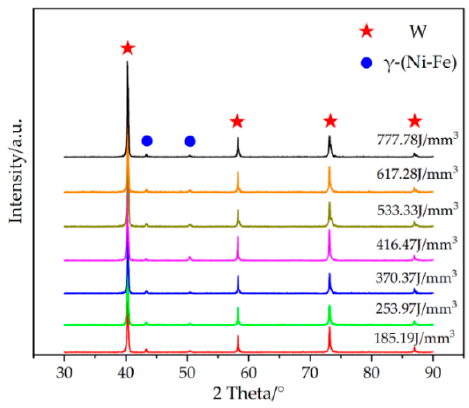
Figure 11. The XRD pattern of different VED.